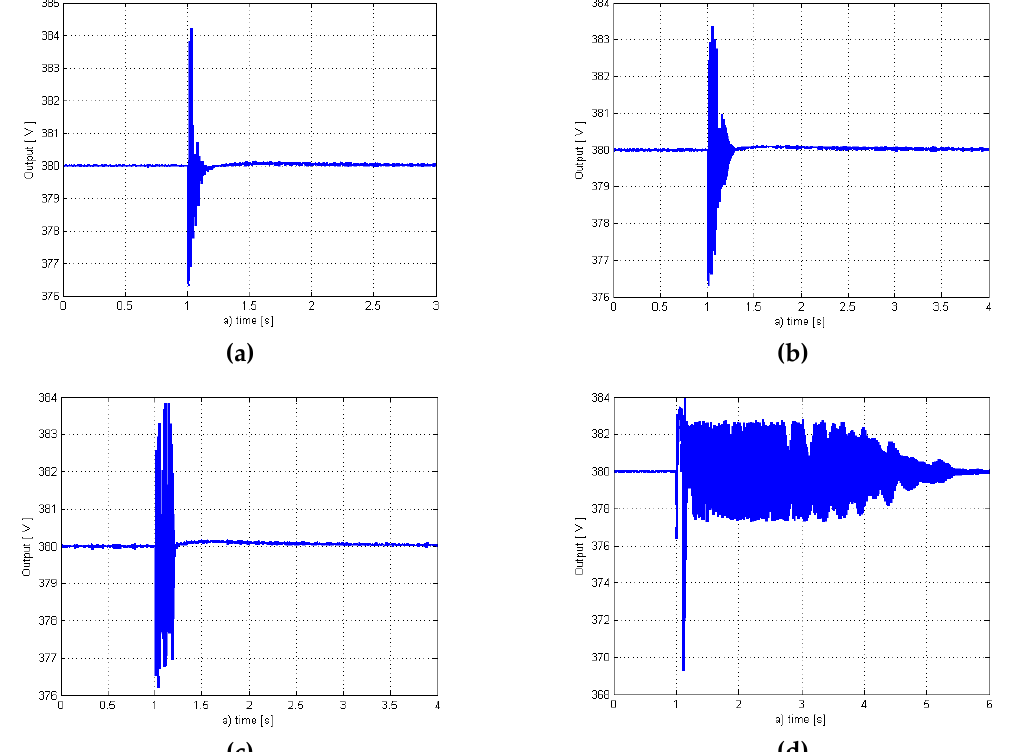
Figure 6. ( a ) Controlled output (terminal voltage)— ρ = 0.0001 ( ∆ R = 7%); ( b ) Controlled output (terminalvoltage)— ρ = 0.001( ∆ R = 7%); ( c )Controlledoutput(terminalvoltage)— ρ = 0.01( ∆ R = 7%); Figure 6. (a) Controlled output (terminal voltage)— (cid:2025) = 0.0001 ( (cid:1986)(cid:1844) = 7% ); (b) Controlled output ( d ) Controlled output (terminal voltage)— ρ = 0.1 ( ∆ R = (terminal voltage)— (cid:2025) = 0.001 ( (cid:1986)(cid:1844) = 7% ); (c) Controlled output (terminal voltage)— (cid:2025) = 0.01 ( (cid:1986)(cid:1844) = 7% ); (d) Controlled output (terminal voltage)— (cid:2025) = 0.1 ( (cid:1986)(cid:1844) = 8% )